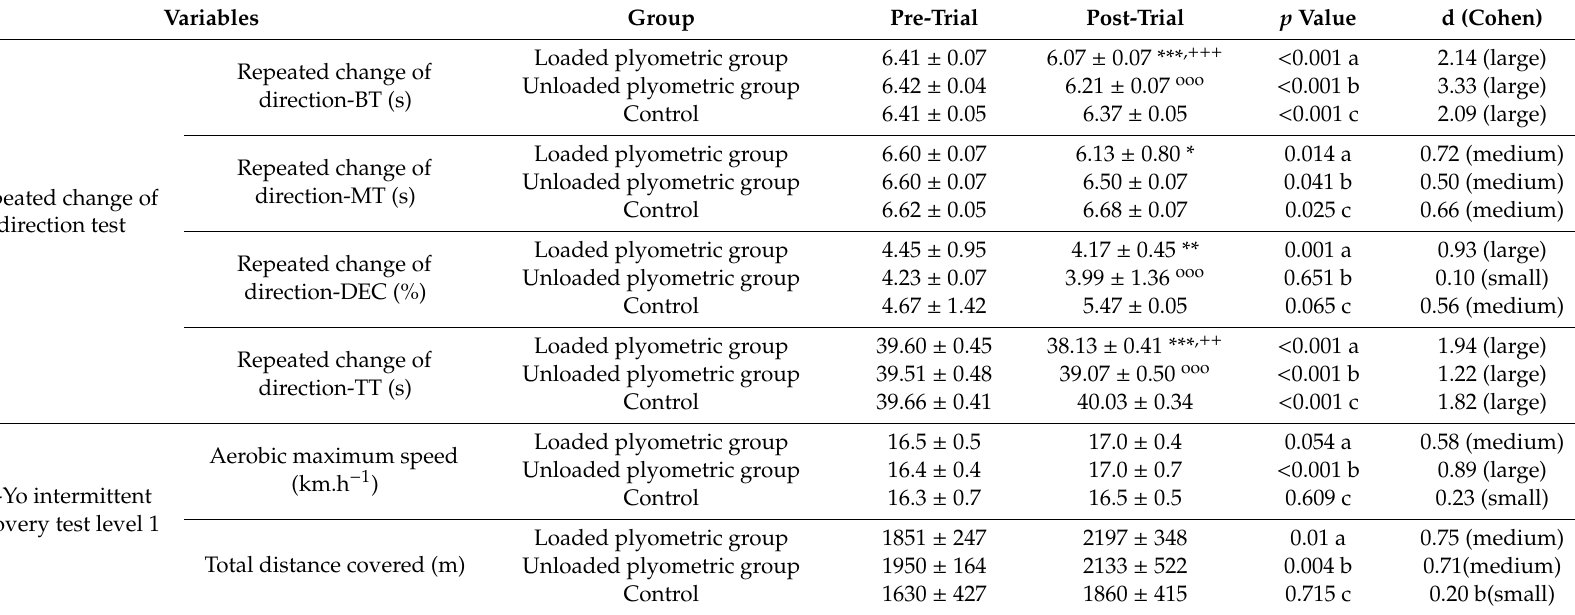
Table 5. Comparison of repeated change of direction and YYIRTL1 performance between groups before (pre) and after (post) the 10-week trial. Variables